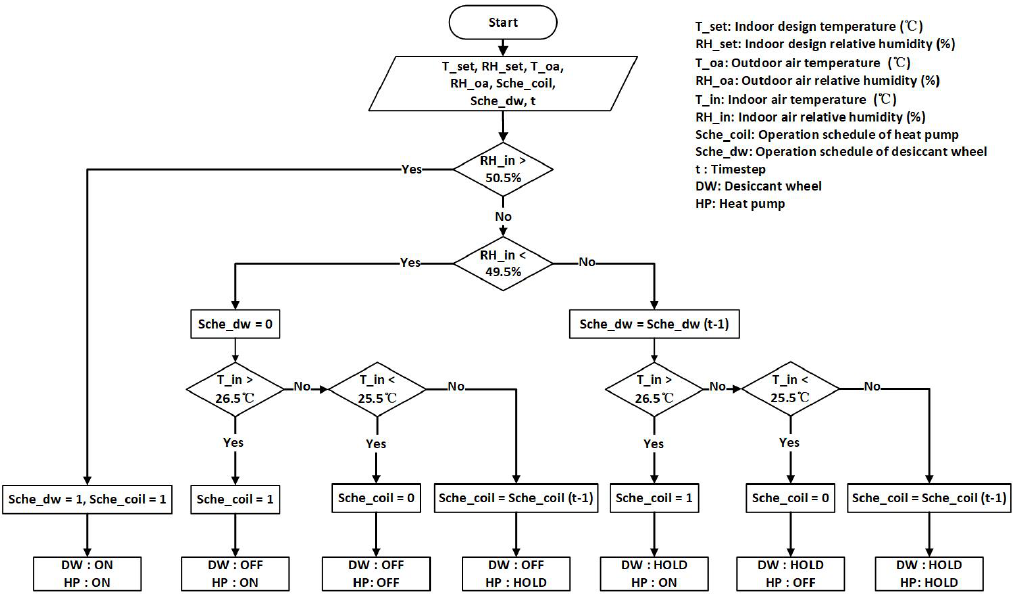
Figure 2. HPDC system control strategies.